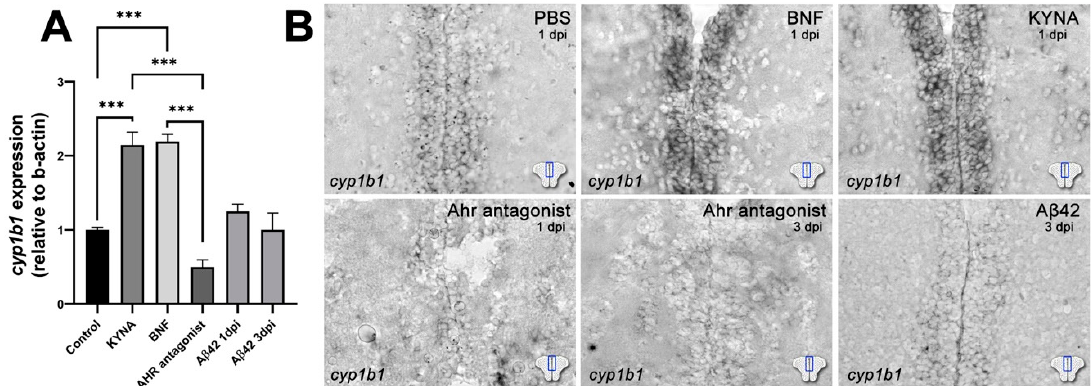
Figure 2. Ahr2-dependent cyp1b1 expression is regulated by A β 42 and KYNA in the adult zebrafish brain. ( A ) Normalized expression levels of cyp1b1 in zebrafish telencephalon injected with control vehicle (PBS), KYNA, BNF, Ahr antagonist or A β 42. ( B ) In situ hybridization for cyp1b1 in control, BNF, KYNA, antagonist and A β 42 injected brains. Note the reduction of expression with the Ahr antagonist and A β 42 and increase with BNF or KYNA. Scale bars equal 50 µ m. Statistical calculations and values are provided in Table S1.